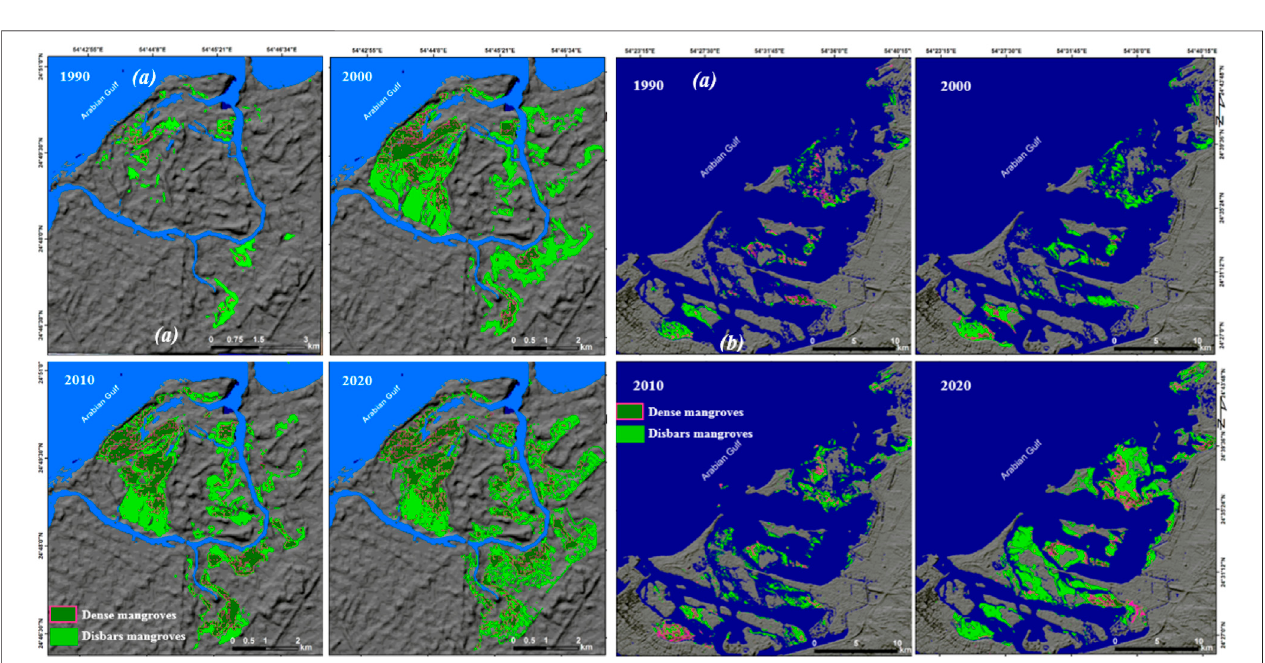
FIGURE 9 | Spatiotemporal variation of mangrove forests on the coastal area of Ras Ghanada (left) and Abu Dhabi – Saadiyat – Shlelia strip (right) for the years from 1990 to 2020.